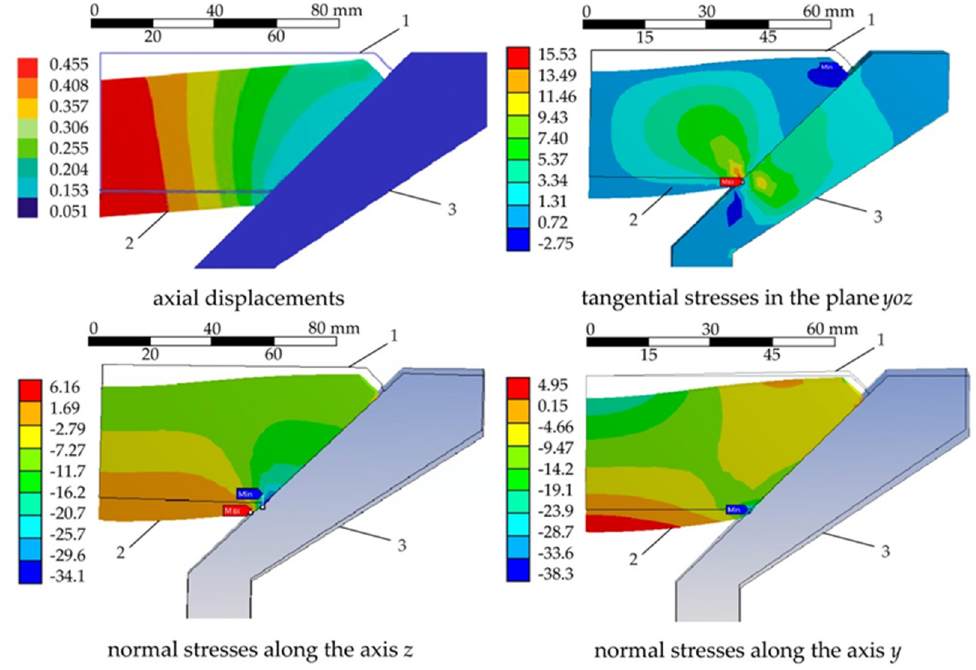
Figure 5. Patterns of stress–strain behaviour of the translucent element: 1—initial position; 2—after deformation; 3—porthole body.